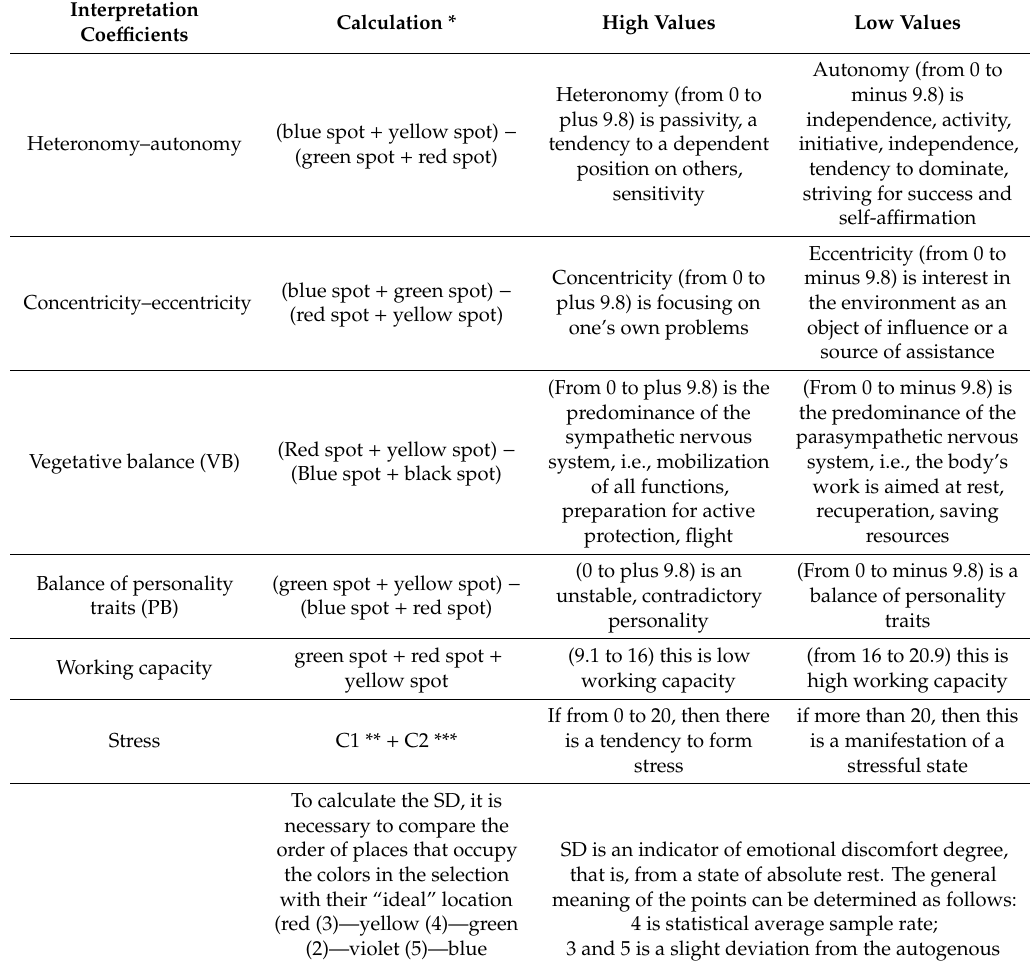
Table A1. Calculation and description of interpretation coe ffi cients for M. Lusher’s test, developed by G.A.